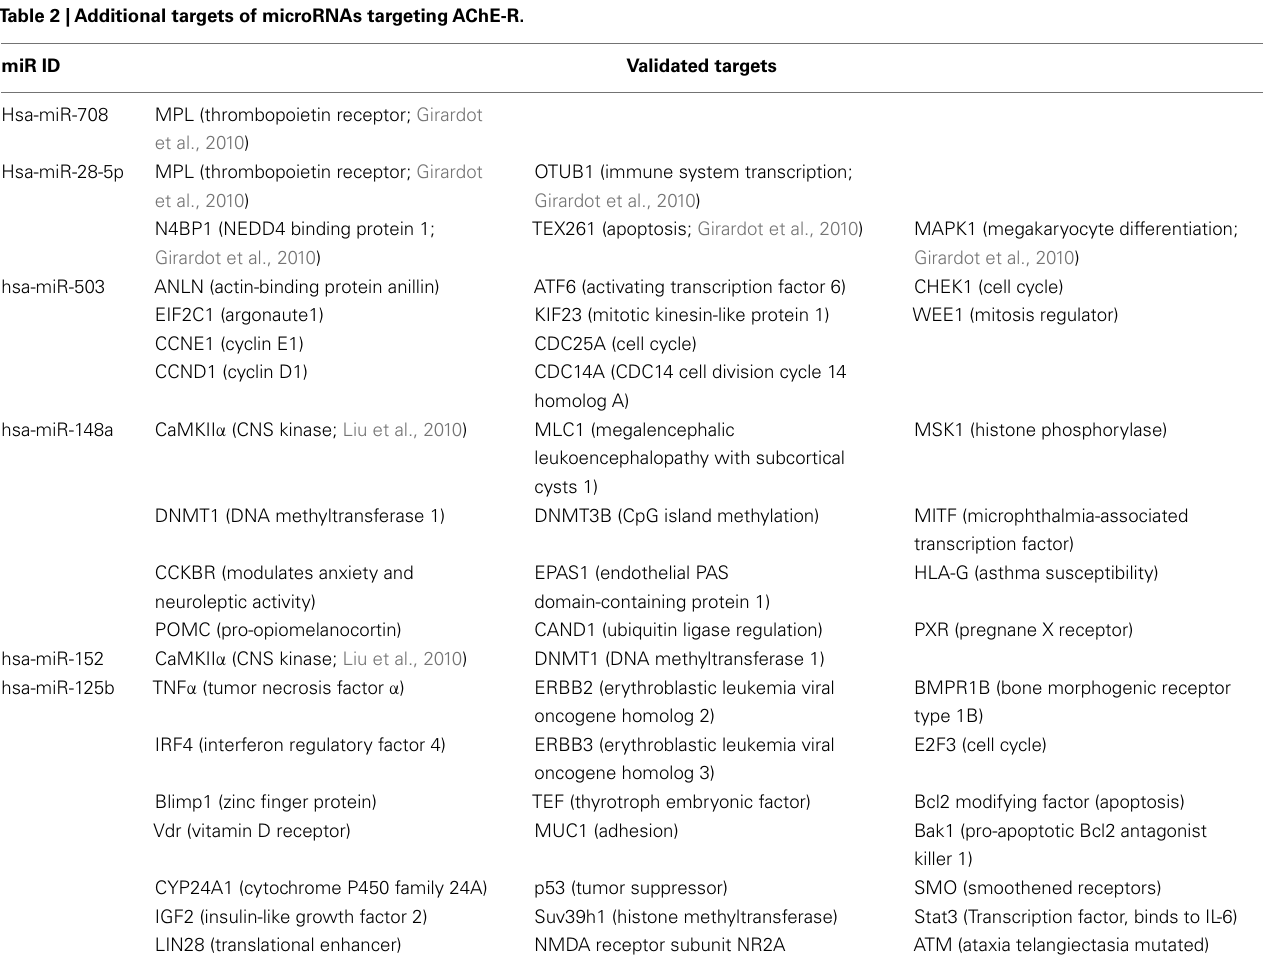
Table 2 |Additional targets of microRNAs